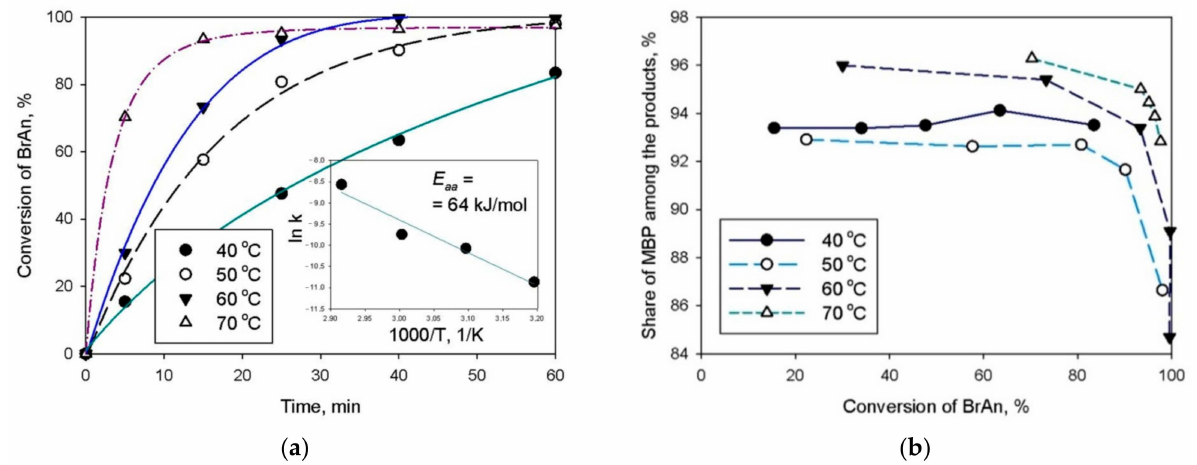
Figure 8. Influence of temperature on the dependence of BrAn conversion vs. time ( a ) and on the “selectivity” with respect to MBP vs. BrAn conversion ( b ); other reaction conditions: 1 mmol of BrAn, 2.5 mmol of PBA, 3.0 mmol of NaOH, 900 rpm, and 30 mg of reduced